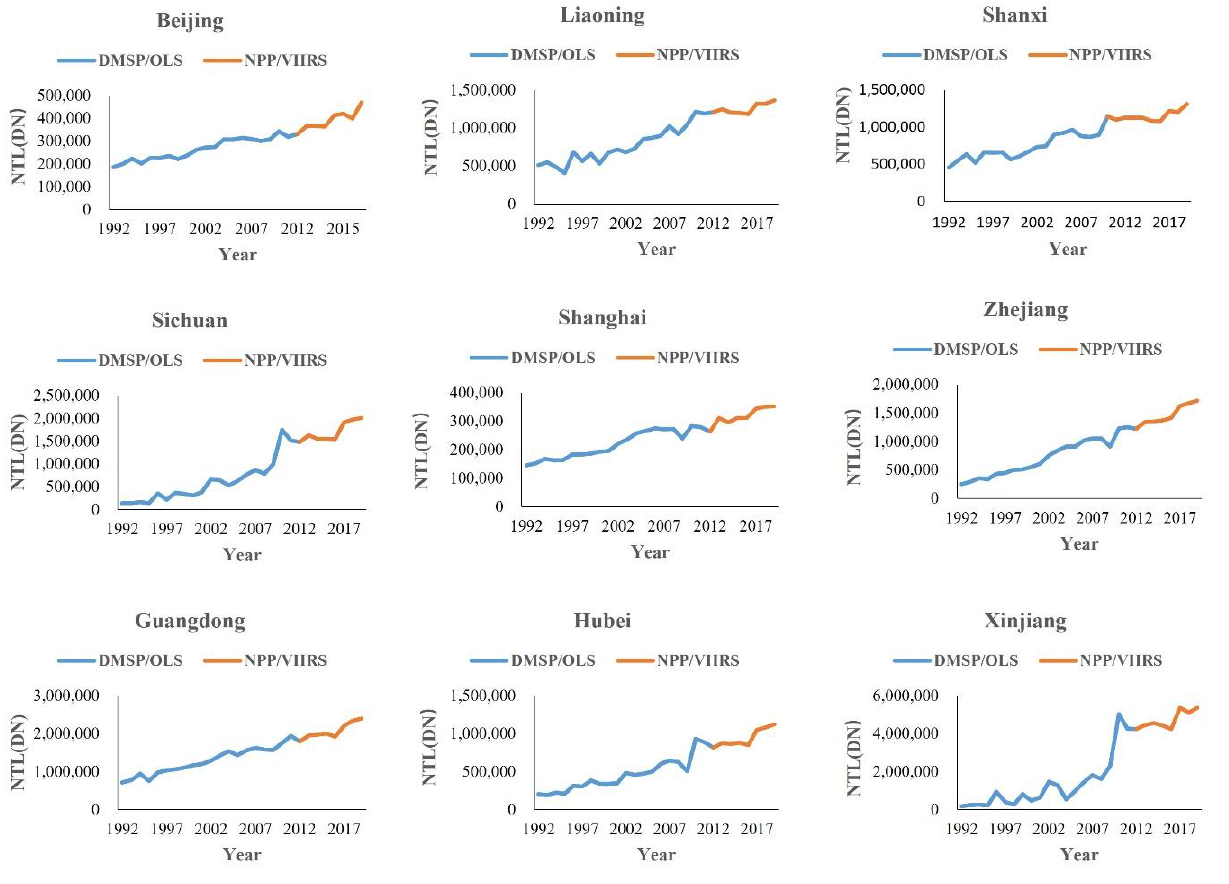
Figure 6. The statistical value of the calibrated NTL data in selected Chinese provinces from 1992 to 2019.